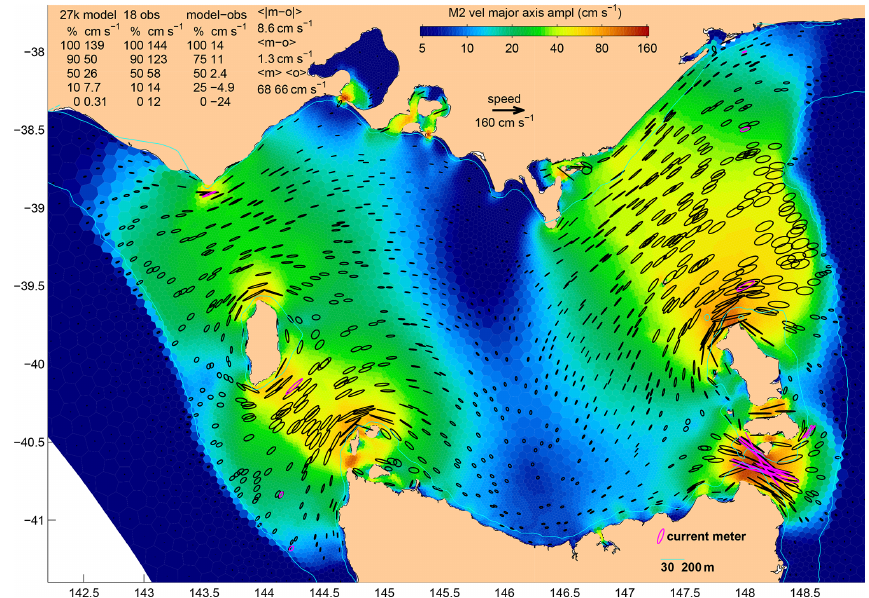
Figure 6. Amplitude of the M2 major axis velocity for Bass Strait; otherwise like Fig. 5, except that percentiles of the model at the locations of the observations are not